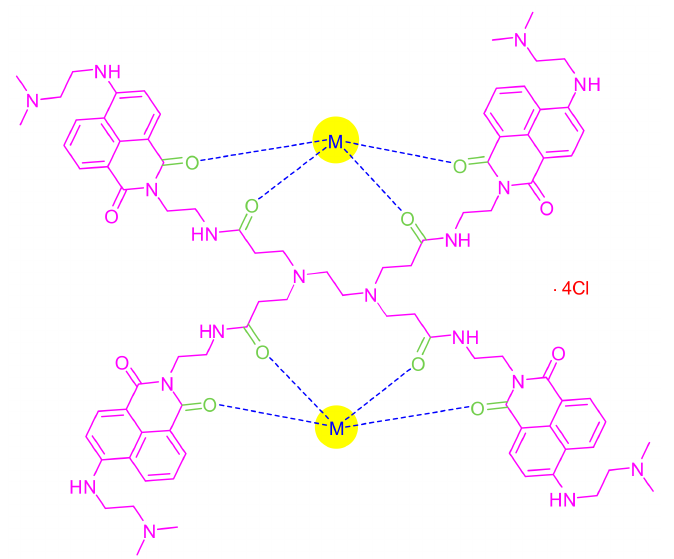
Figure 8. The proposed structure of the synthesized metal–FCD complexes (M: Zn 2+ , Cd 2+ , or Hg 2+